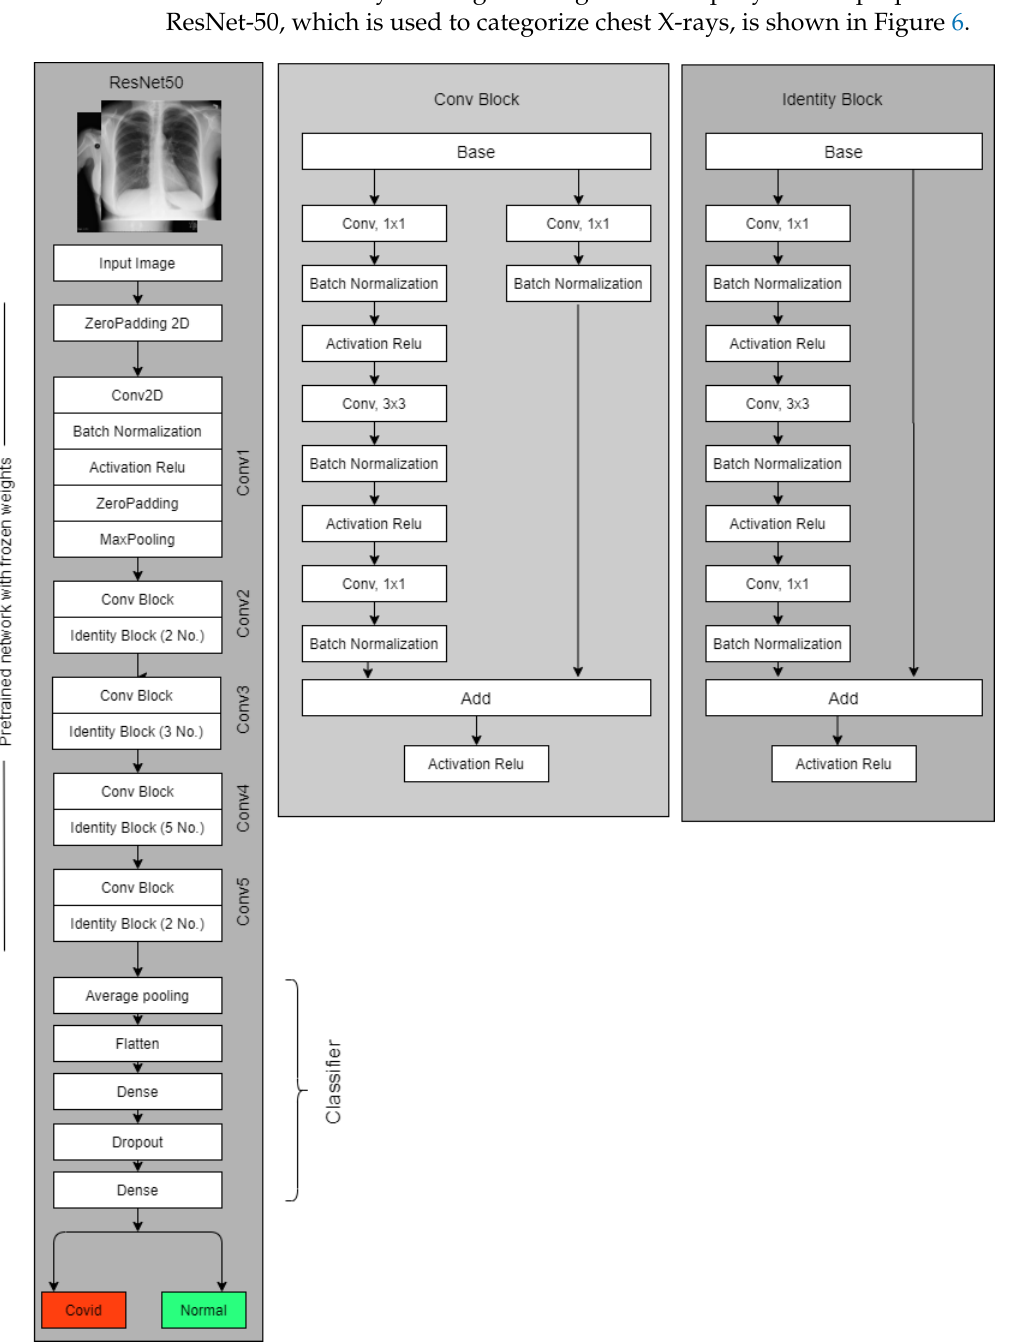
Figure 6. Modified Resnet50 to Classify COVID and Normal images. For the four classes, similar architecture is applied and the final dense layer has an output size of four to detect normal, COVID, Lung Opacity and non-COVID viral pneumonia